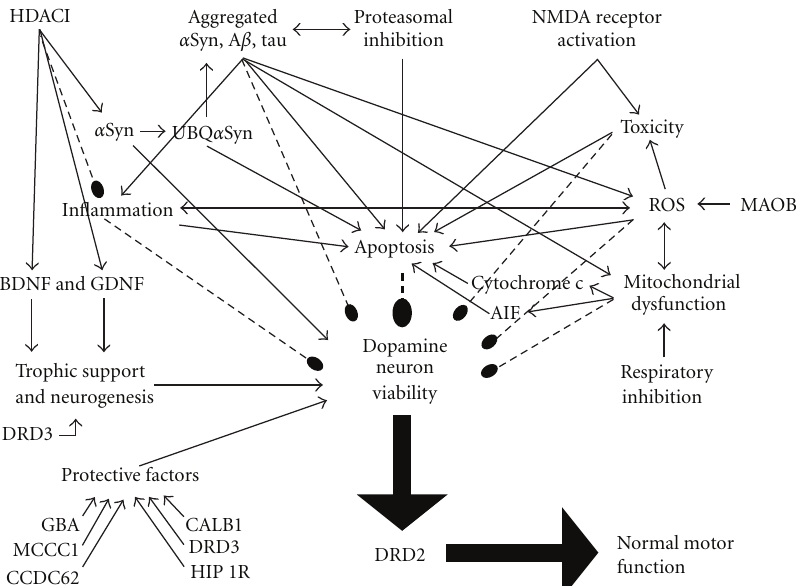
Figure 1: Factors a ff ecting the viability of dopamine neurons. Relations terminating in an arrowhead indicate facilitation, those with double arrowheads indicate mutual facilitation, and dashed lines terminating in a bulb indicate inhibition. Though still being settled, recent data suggest that alpha-synuclein ( α Syn) is neuroprotective whereas monoubiquitylated α Syn, aggregated α Syn, and other pathogenic proteins promote neurodegeneration. H3 histone deacetylase inhibition (HDACI) increases α Syn, brain derived neurotrophic factor (BDNF), and glial derived neurotrophic factor (GDNF), supporting neuronal synapses ( α Syn) and providing trophic support for neurons and promoting neurogenesis (BDNF and GDNF). Neurotrophism appears to be facilitated by D3 dopamine receptor stimulation. HDACI also inhibits inflammation. Aggregated proteins inhibit the proteasome, promote reactive oxygen species (ROS), mitochondrial dysfunction, inflammation, and apoptosis, and impair neuronal viability. Inhibition of the proteasome results in reduced elimination of obsolete proteins, increases in aggregated protein species, facilitates apoptosis, and impairs neuronal viability. N-methyl-D-aspartate (NMDA) receptor activation by glutamate promotes neurotoxicity and apoptosis. Generation of peroxide radicals by MAOB promotes ROS. ROS and inflammation mutually promote each other, and each can induce apoptosis. Mitochondrial dysfunction and ROS also mutually promote each other. Impaired mitochondrial respiration through inhibition of respiratory chain complexes (I-IV) can produce mitochondrial dysfunction. Mitochondrial dysfunction leads to the loss of the mitochondrial membrane potential, opening of the mitochondrial permeability transition pore, and the release of cytochrome c and apoptosis inhibiting factor (AIF). Cytochrome c and AIF each independently trigger apoptosis. Protective factors against neurodegeneration include GBA, DRD3, CALB1, and other gene products. Thus, neurodegenerative processes include pathogenic proteins, proteasomal dysfunction, glutamate and other toxic molecules, NMDA receptor activation, ROS, mitochondrial dysfunction, apoptotic pathway activation, and subsequent neuroinflammation, in turn potentially inducing further ROS and apoptosis. Neuroprotective factors include GBA, MCCC1, CCDC62, HIP1R, DRD3, CALB1, α Syn, HDACI, BDNF, and GDNF. Neuroprotective factors promote while neurodegenerative processes impair the viability of the dopamine neuron. Nigral dopamine neurons promote normal motor functioning by release of dopamine on striatal D2 receptors, transcribed from the DRD2 gene, and reduced D2 stimulation is associated with Parkinson motor